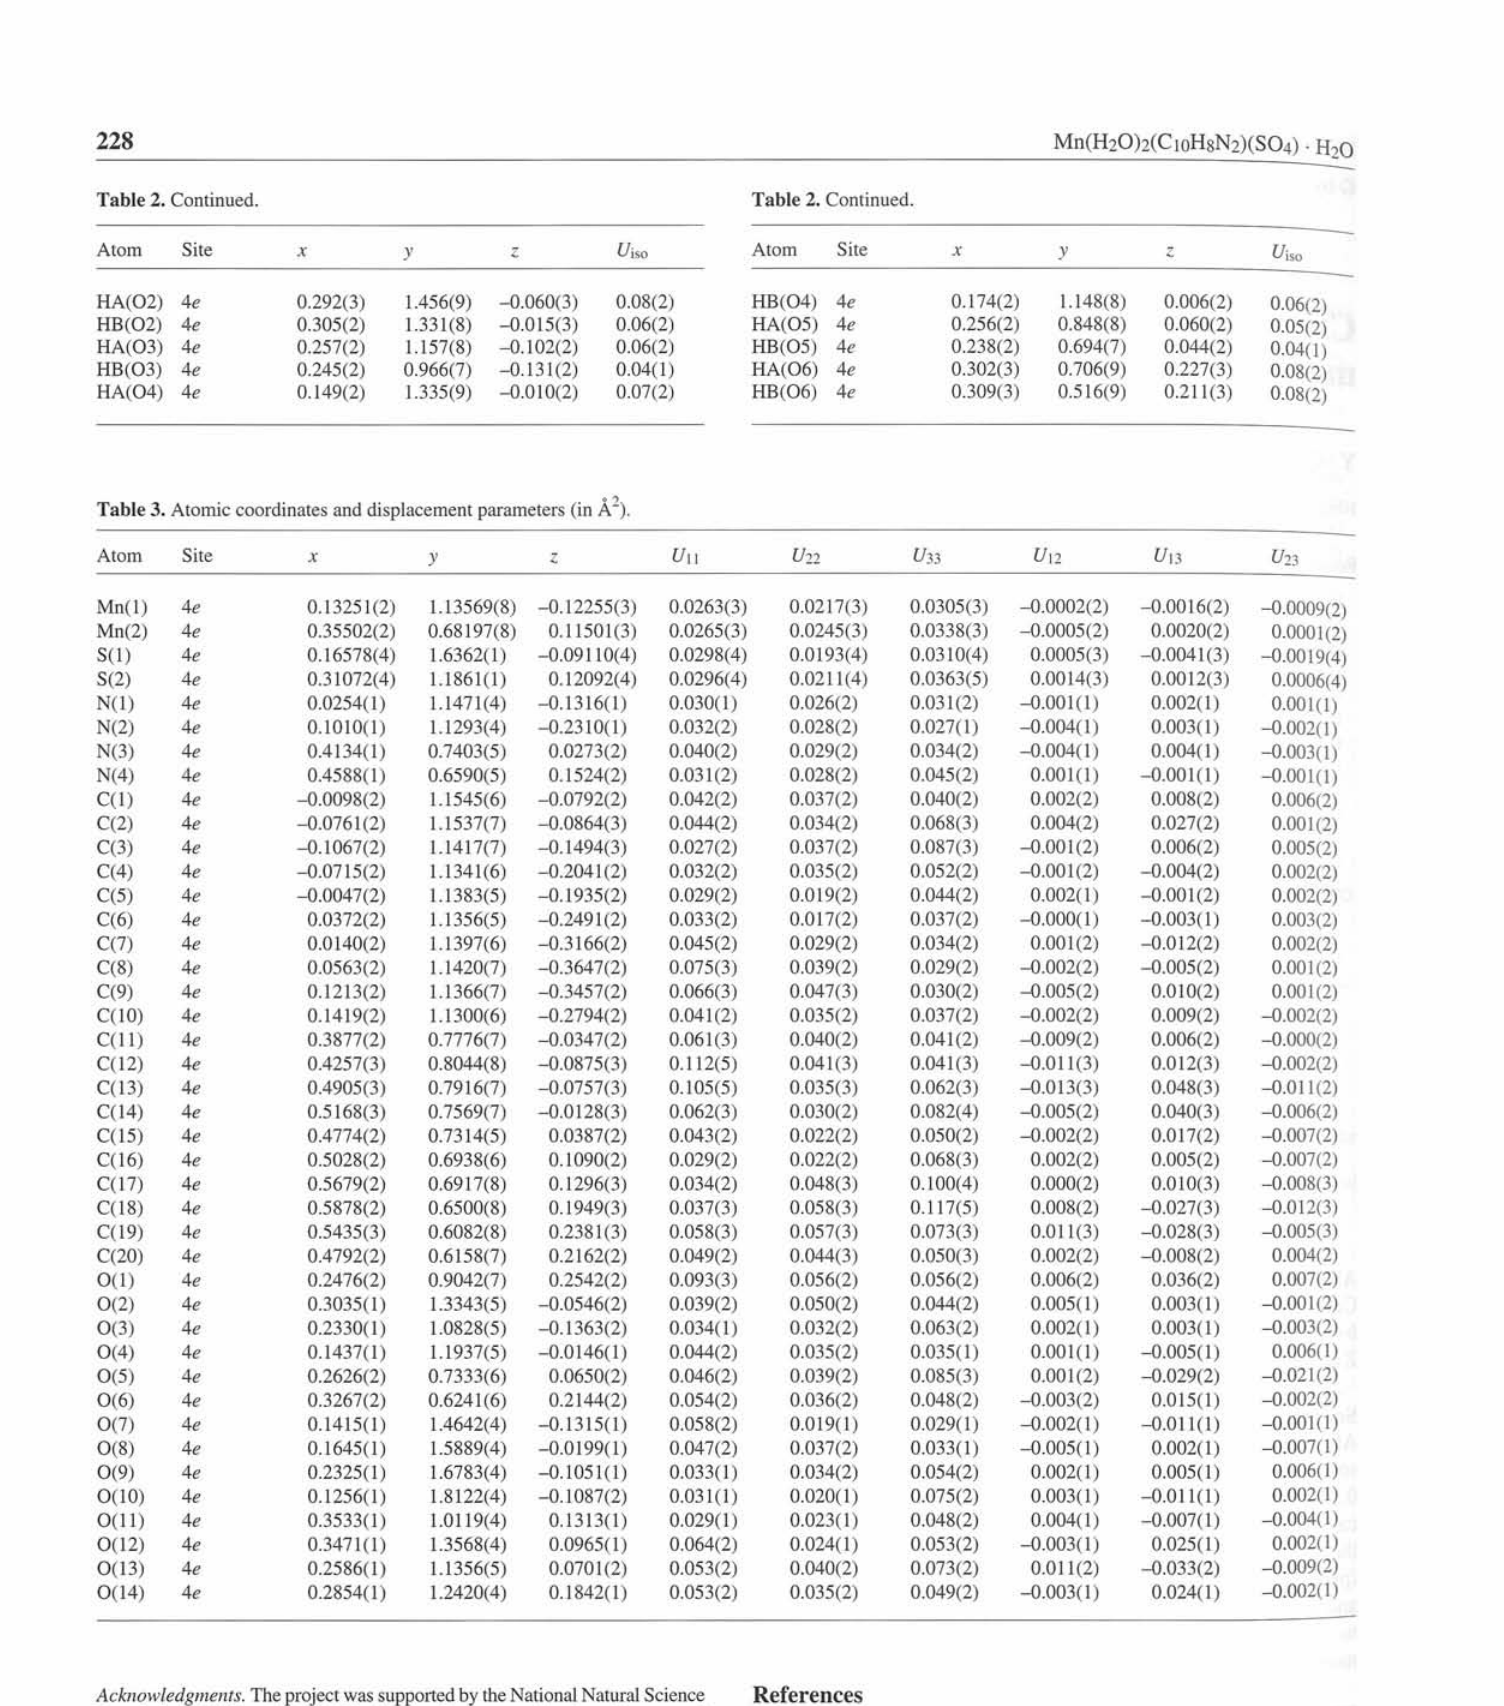
0 Table 3. Atomic coordinates and displacement parameters (in